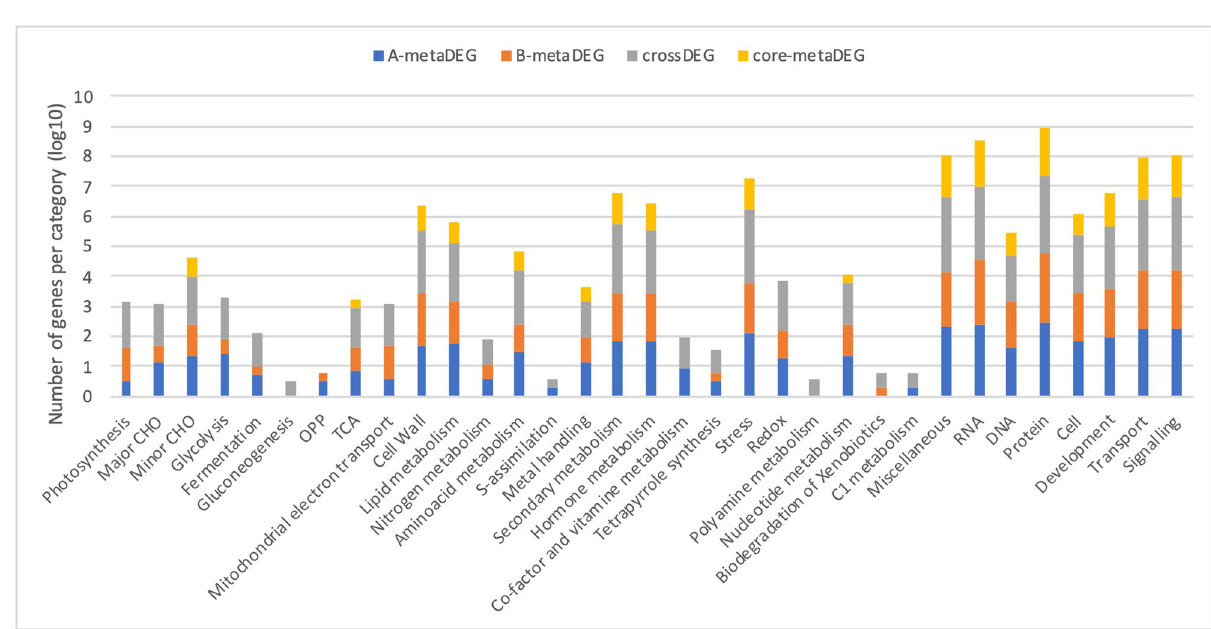
Figure 3. Number of genes annotated in each Mercator categories for the A-metaDEG, B-metaDEG, crossDEG and core-metaDEG. The number of genes is represented in